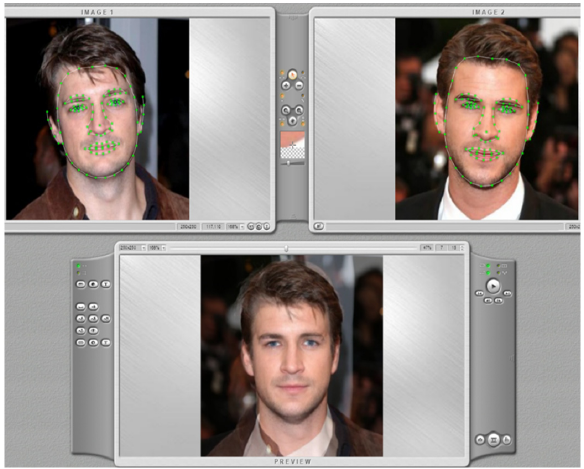
Figure 2. Morphed image created by merging two subjects in the tool FantaMorph (Version-5). In the recent past, a lot of work has been done on generative adversarial networks (GANs). These methods are also employed for face morphing generation [9,10]. These morphs are highly dependent upon the properties of GAN used for generation. Moreover, it can pose a serious threat to morph detection if the GAN is new or unknown. Depending upon these factors, these deep learning-based morphs can be very challenging for face recognition systems. 2.2. Source Databases Many datasets are presented in the literature for biometrics and face recognition [11– 19]. For the training and testing of morph attack detection models, the databases shown in Table 1 are used. These databases are used to create morphed images utilized in morph attack detection research studies. It can be seen that different databases have a diverse range of image variations. High image variation is better for creating a generalized morph attack detection model. The number of subjects also facilitates training a generalized and robust model. Table 1. Details about source databases and morph attack detection methodologies. Datasets